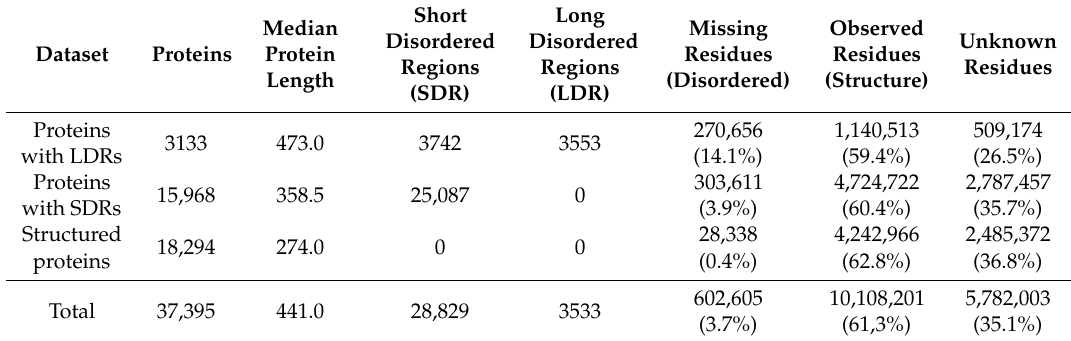
Figure 3. Intrinsically disordered region (IDR) definition at the protein level. Example of the majority and zero consensus definitions when more than one structure maps to the same protein sequence. Missing residue regions are in red, structured parts in blue and unknown residues as a gray line. The N-terminus is always disordered with an IDR according to the zero consensus. PDB 1 limits the length of the IDR in the zero consensus because it is the only one which has structured residues in the region between the black lines. Consequently, the IDR of the majority consensus is longer and contains those residues which are missing in at least 3 out of 5 PDB chains (more than 50%). Unknown residues, i.e., those not considered to grow the crystal, are excluded and do not affect the consensus definitions. Table 1. Dataset composition. The number of proteins, short and long disordered regions, residues, and median protein length is shown for proteins with long disordered regions (LDR, region length 30 + ), short disordered regions (SDR, region length 5 + and < 30) and structured proteins without missing residues or with disordered regions shorter than 5 residues. Disordered regions are defined using the majority rule. Residues are unknown if they are not covered by any PDB structure in the corresponding UniProt entry. More than one disordered region per protein may be present. Percentages are rounded and may sum up to more than 100.